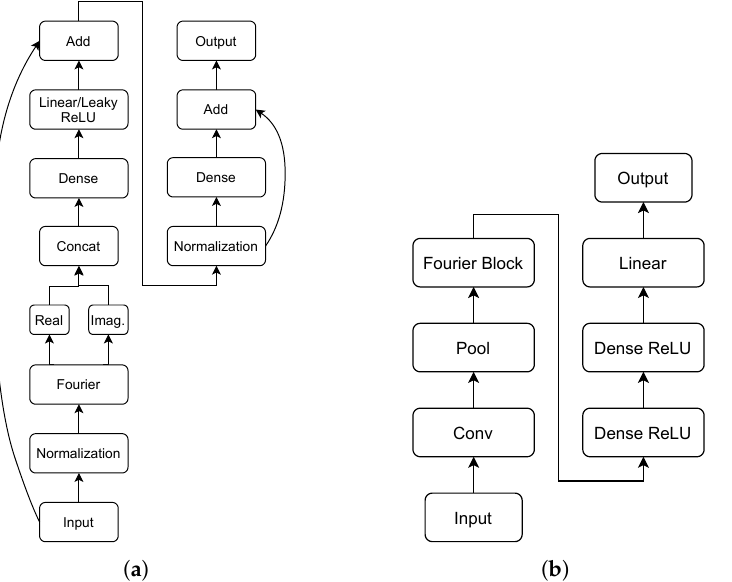
Figure 5. The proposed NFED neural network and the Fourier block architecture. ( a ) Fourier block; ( b ) NFED